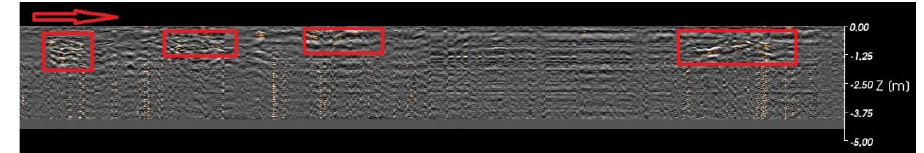
Figure 7. Radargram image. The image shows the geophysical alterations corresponding to the archaeological features described in the previous figure. Some of the signals that may correspond to small metallic echoes.